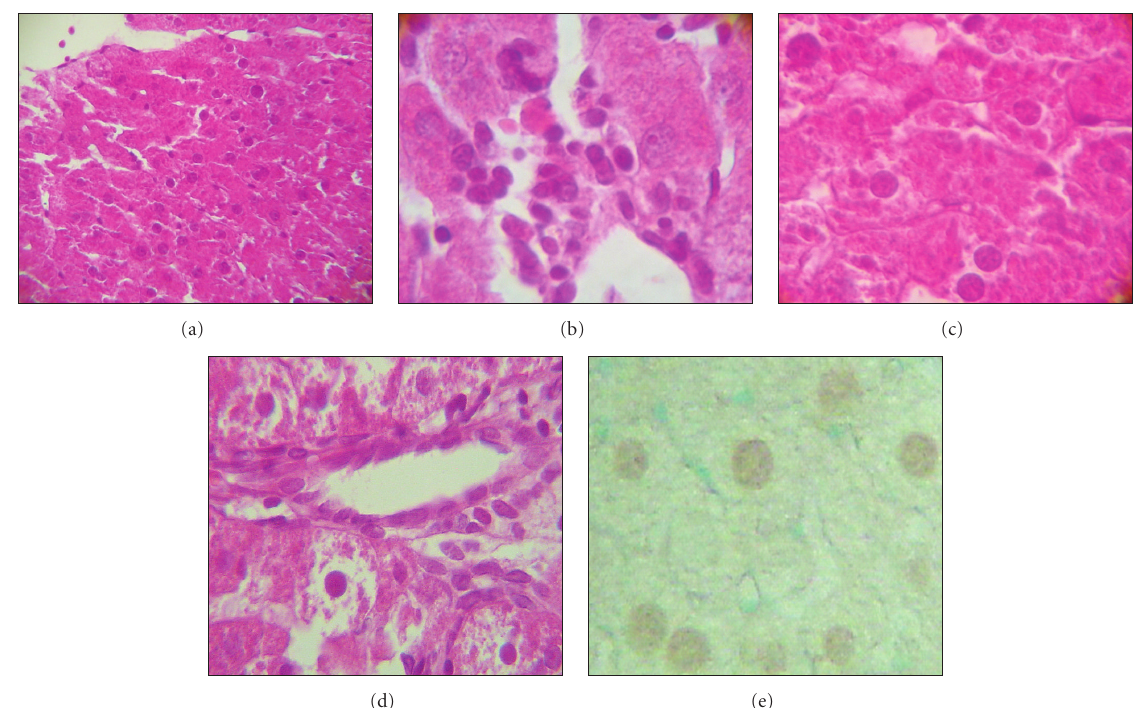
Figure 3: Histological lesions in the liver of rats exposed to lead. (a) Structure of a classic lobule with severe damage (H&E stain × 20). (b) Inflammatory cell infiltration (H&E stain × 64). (c) Irregular membrane cell, condensed and eosinophilic cytoplasm (H&E stain × 64). (d) Hyperchromatic and pyknotic nuclei (H&E stain × 64). (e) Apoptotic parenchyma cells (TUNEL stain ×